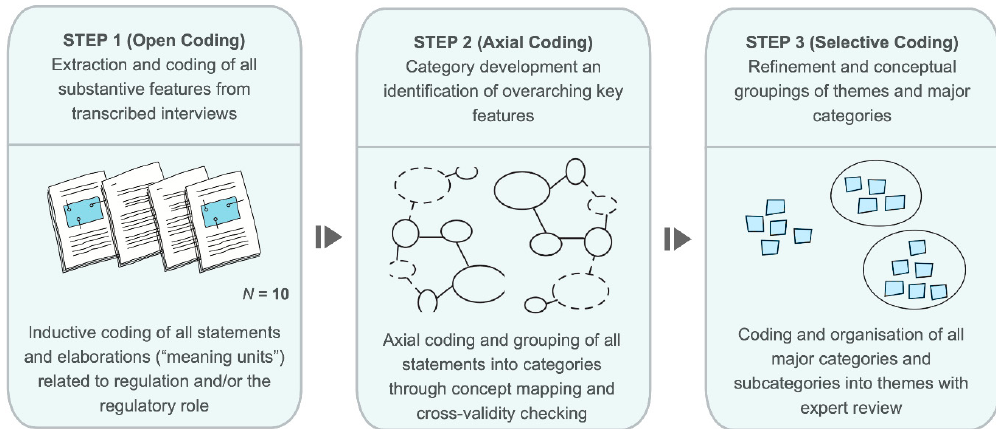
Figure 2. Overview of the data analysis process showing the three main steps of open, axial, and selective coding undertaken. Through this systematic process, data were coded semantically from description to interpretation.